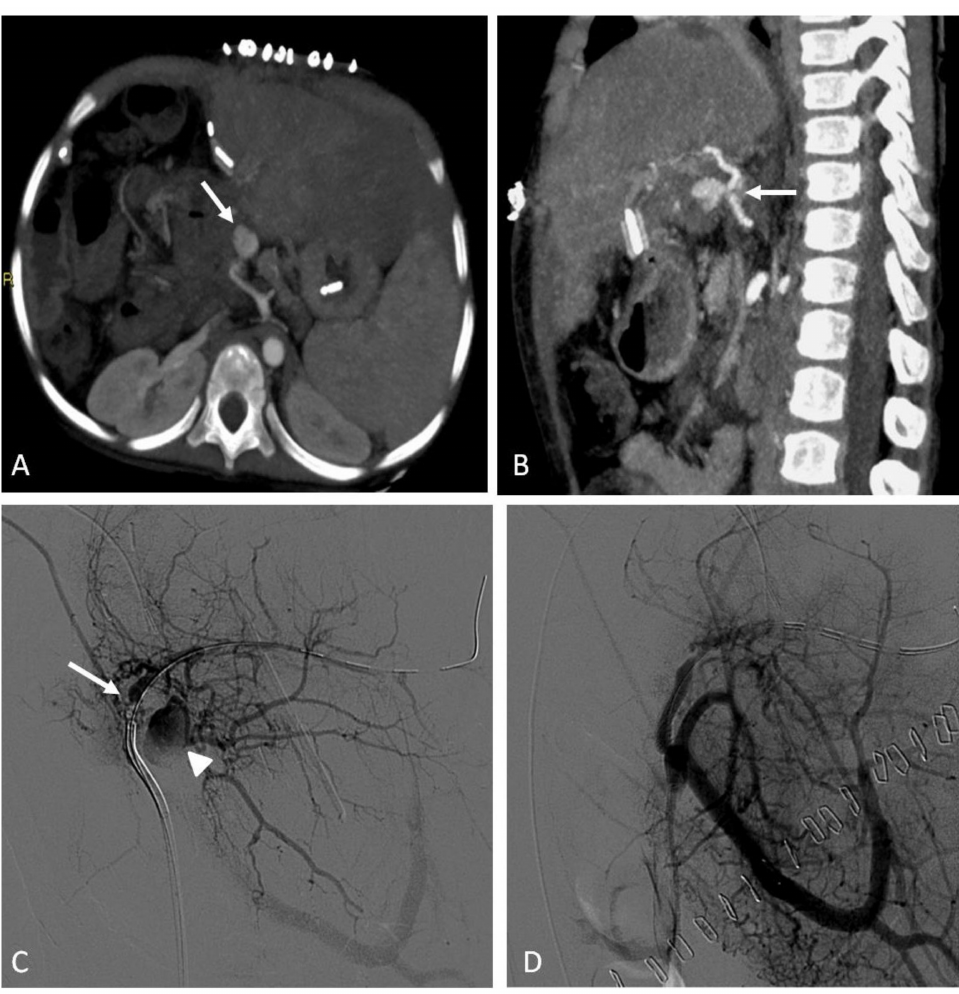
Figure 7. Transcatheter repair with coronary stent graft of a hepatic artery pseudoaneurysm af- ter liver transplant and meso-rex surgery in a 6-year-old female. ( A ) Axial CTA image shows a pseudoaneurysm of the proximal tract of the transplanted hepatic artery (arrow). ( B ) Reformatted coronal CTA image highlights the presence of a hepatic artery stenosis (arrow), associated with the pseudoaneurysm. ( C ) DSA image shows selective 5F catheterization of the hepatic artery, confirming the presence of stenosis (arrow) and pseudoaneurysm (arrowhead); a 0.014” guidewire was advanced beyond the affected tract. ( D ) Control DSA, performed after deployment of two imbricated coronary 3.5-mm balloon expandable stent grafts, shows regular opacification of the artery and disappearance of the